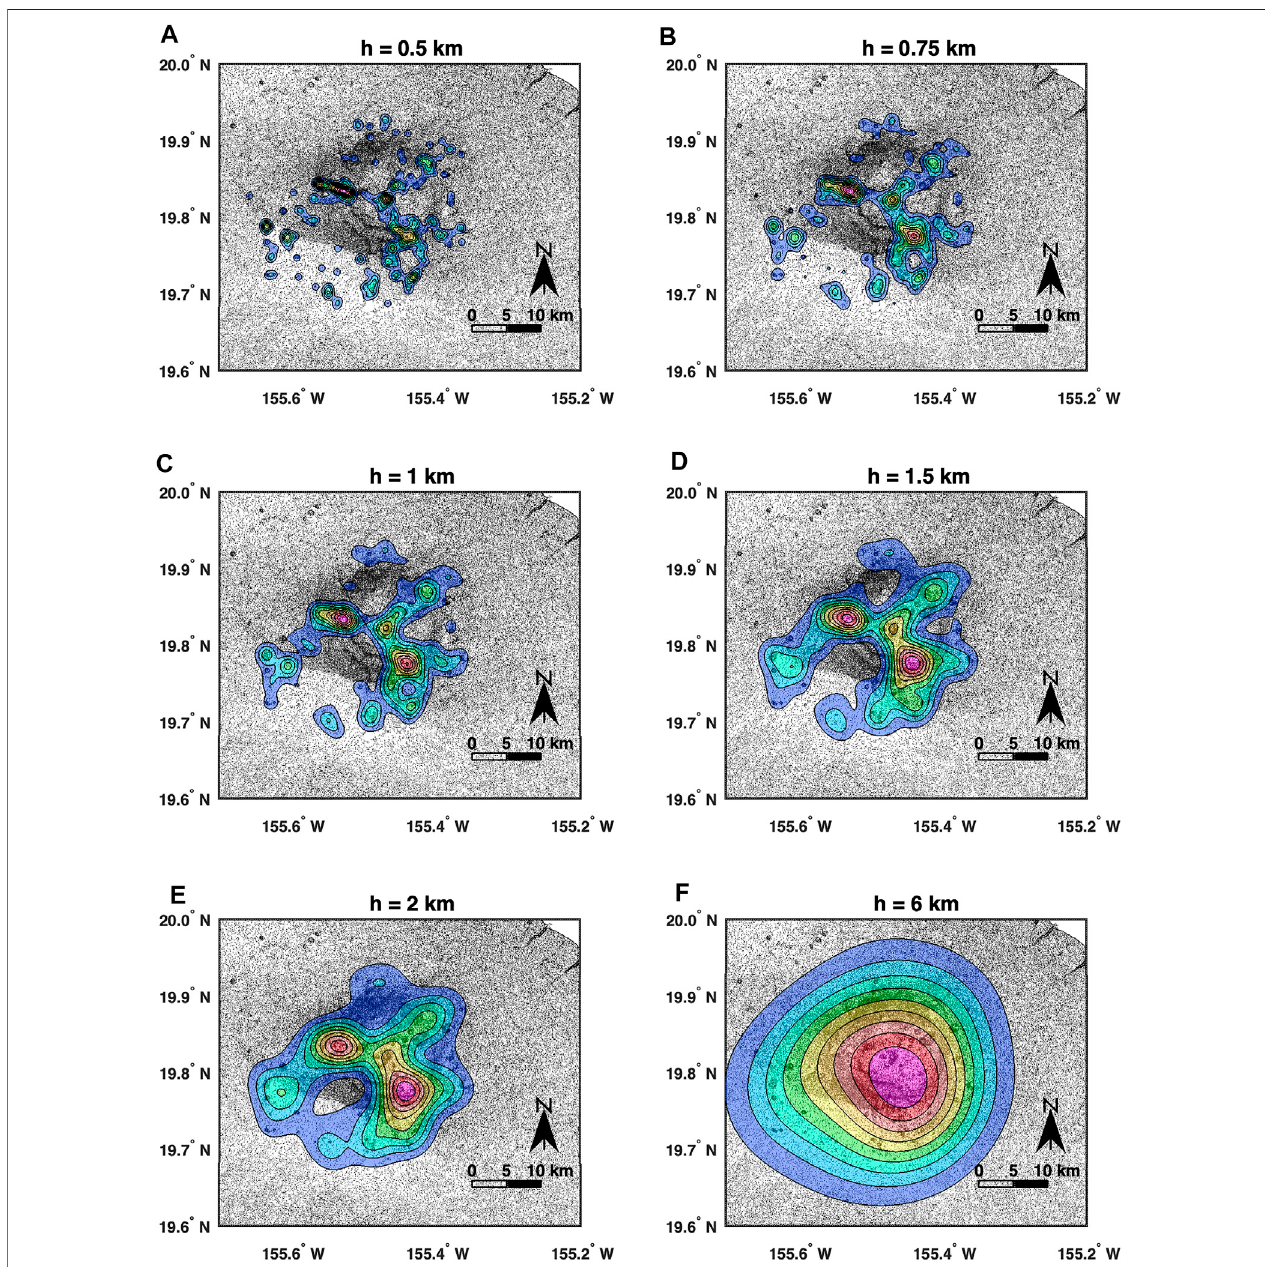
FIGURE 6 | Sequence of PDFs used for exploration of the main features of the PDFs associated with the vent distribution of vents atop Mauna Kea volcano.